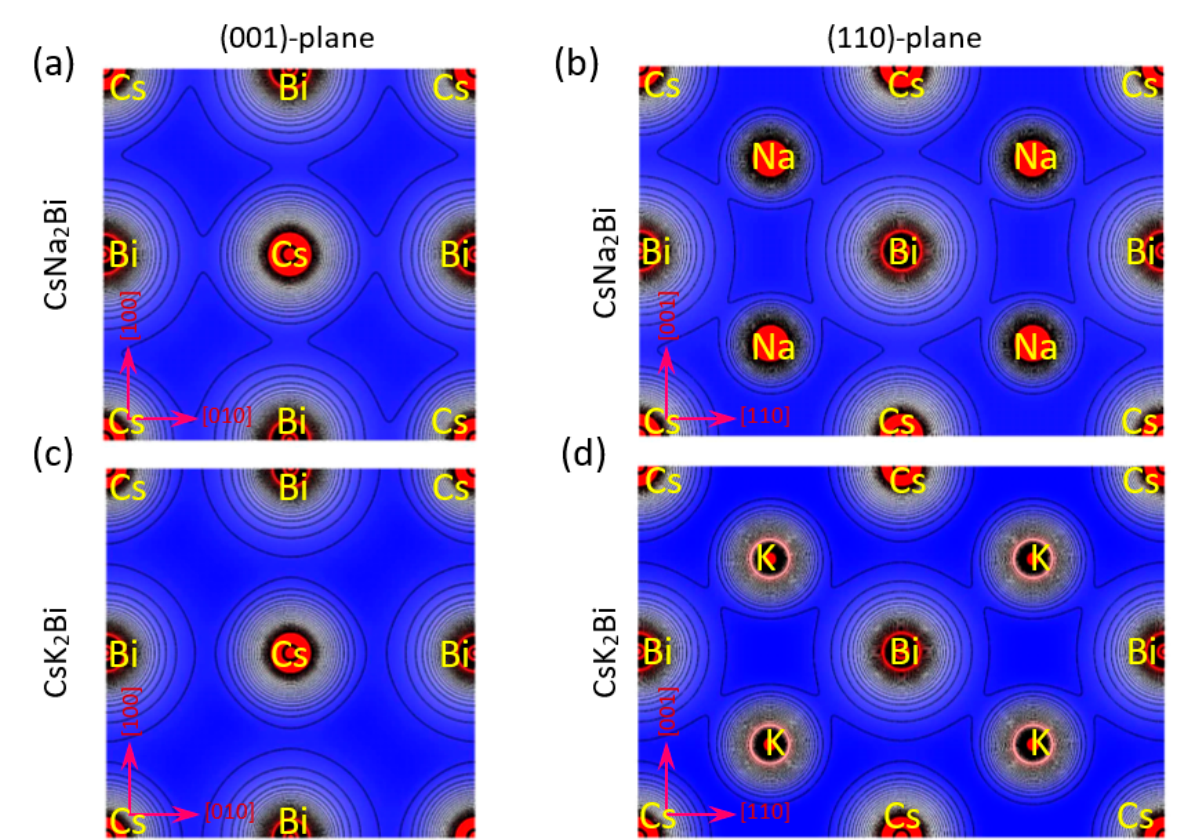
Figure 3. Electronic charge densities in (100) and (110) planes for ( a , b ) CsNa 2 Bi and ( c , d ) CsK 2 Bi compounds. It is evident from the valence charge density contour of the CsNa 2 Bi compound that the Bi charge density overlaps with Na and Cs, pointing to a covalent bond. In addition, the Cs-atom of CsK 2 Bi compound in the (001)-plane has a spherical electron charge density distribution with overlap with Bi and K, pointing to an ionic bond.